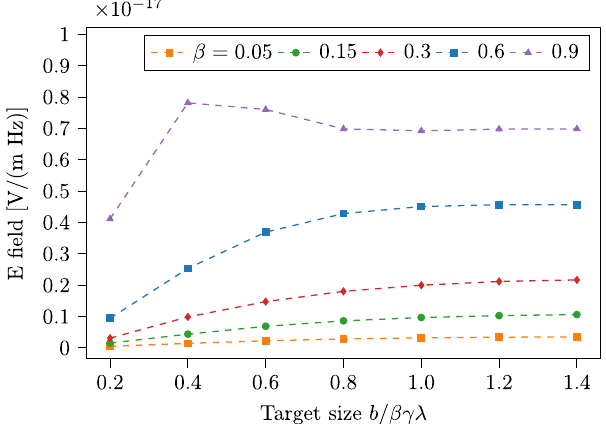
FIG. 4. Electric field spectral amplitude dependence on target